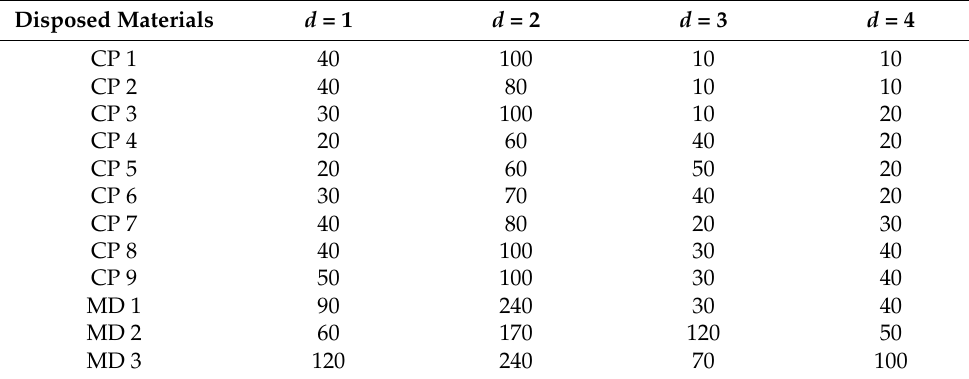
Table 6. Heavy metal pollution quantity of materials.